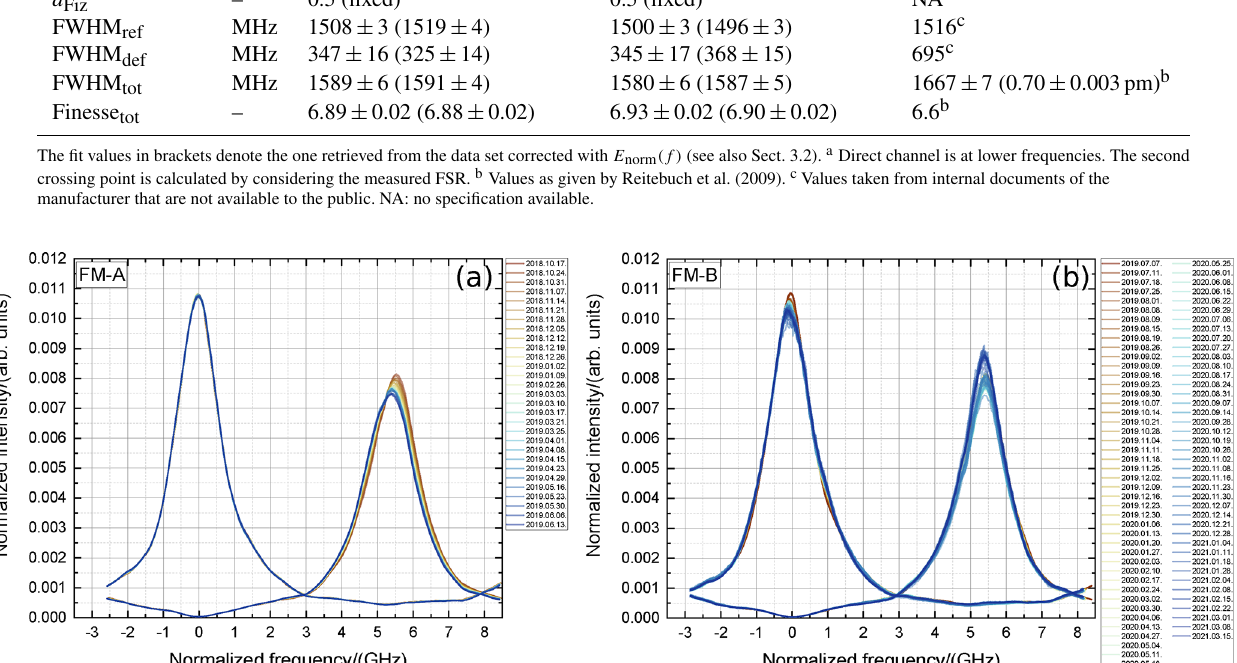
(f ) . The given uncertainty new